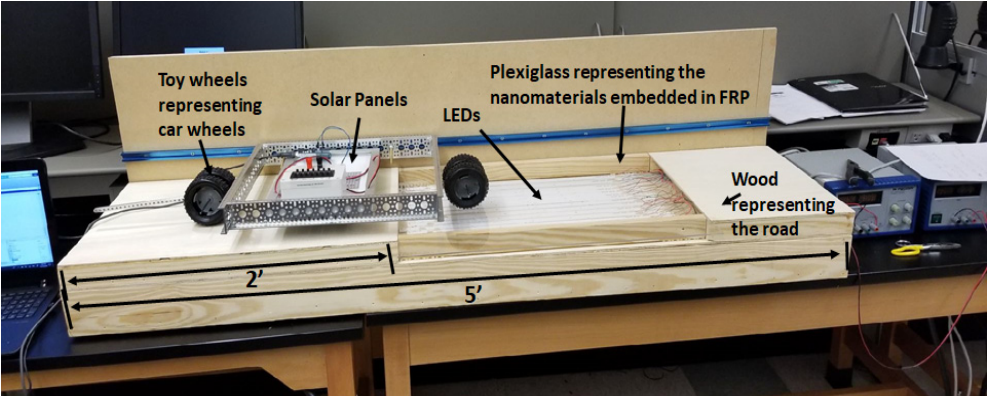
Figure 6. Lab scale proof-of-concept design of the prototype.